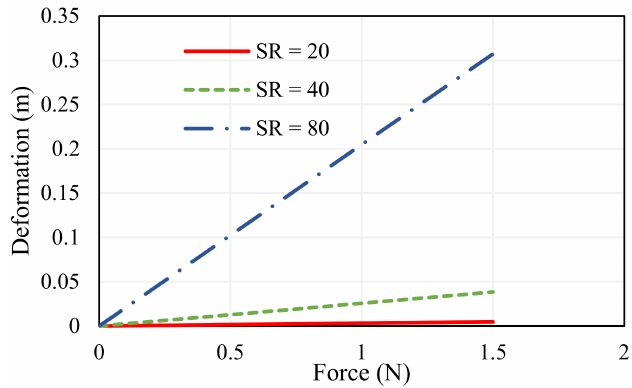
Figure 3. Deflection of the gripping arm for varying slenderness